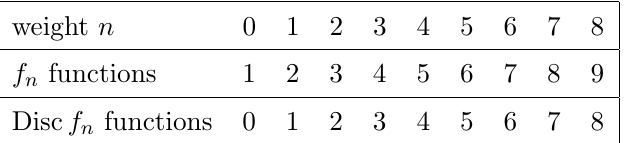
Table 1 . Number of weight n functions in the f space, and in the space of functions after taking a discontinuity in 1 (cid:0) z , holding 1 (cid:0) (cid:22) z (cid:12)xed. Only a single function gets lost in the